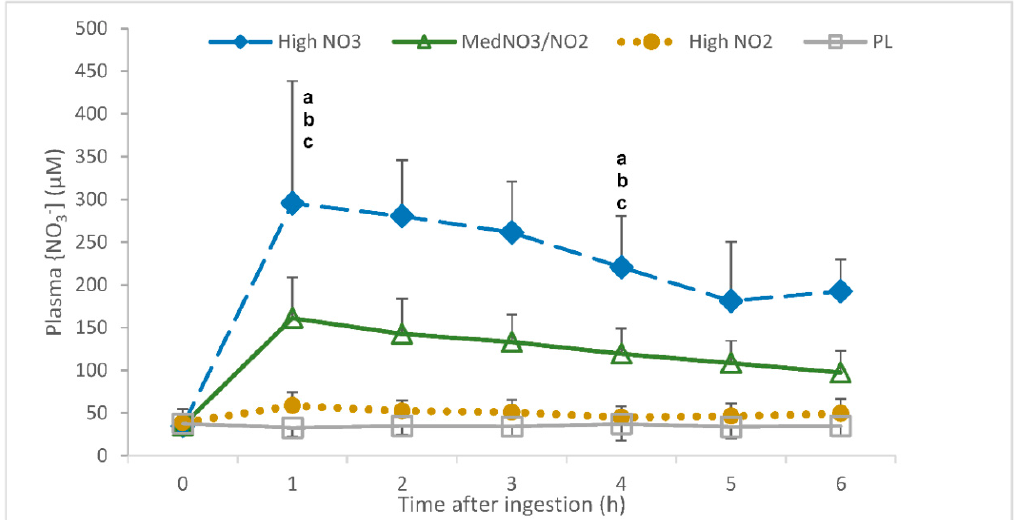
Figure 3. Plasma nitrate concentration ([NO 3 − ]) (uM) over a 6-h period following the ingestion of placebo (PL); high nitrate, low nitrite (HL); low nitrate, medium nitrite (LM); and medium nitrate and medium nitrite (MM) beverages. a Significant difference between HL and PL ( p < 0.05). b Significant difference between HL and LM ( p < 0.05). c Significant difference between HL and MM ( p < 0.05).